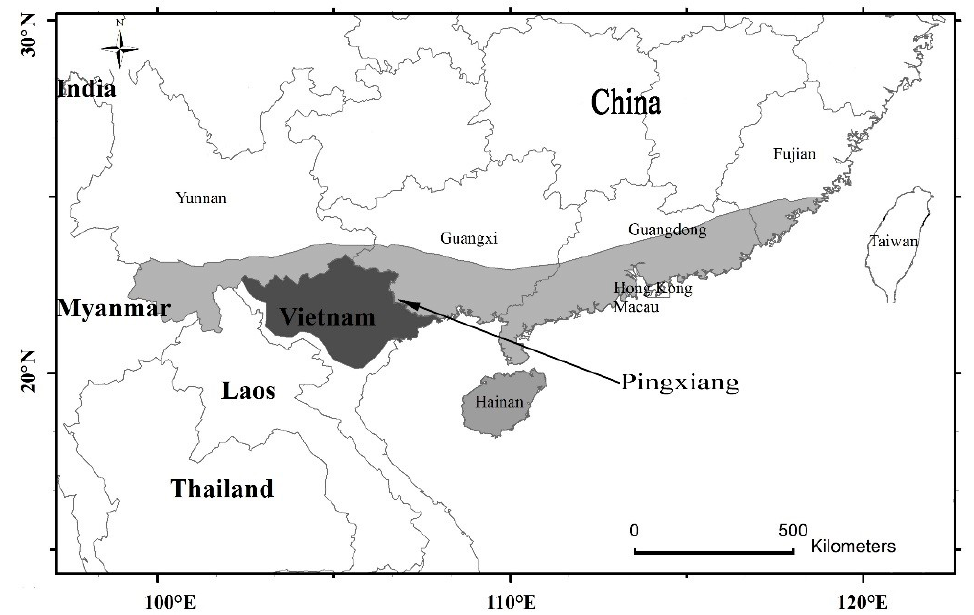
Figure 1. Natural distribution of Manglietia conifera in Vietnam (dark shade) and planted area in China (light